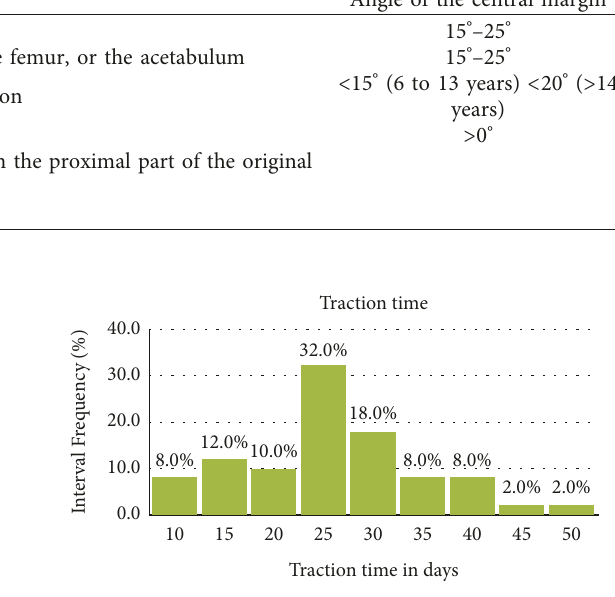
Figure 2: Vertical traction time before application of the Hil- genreiner brace.